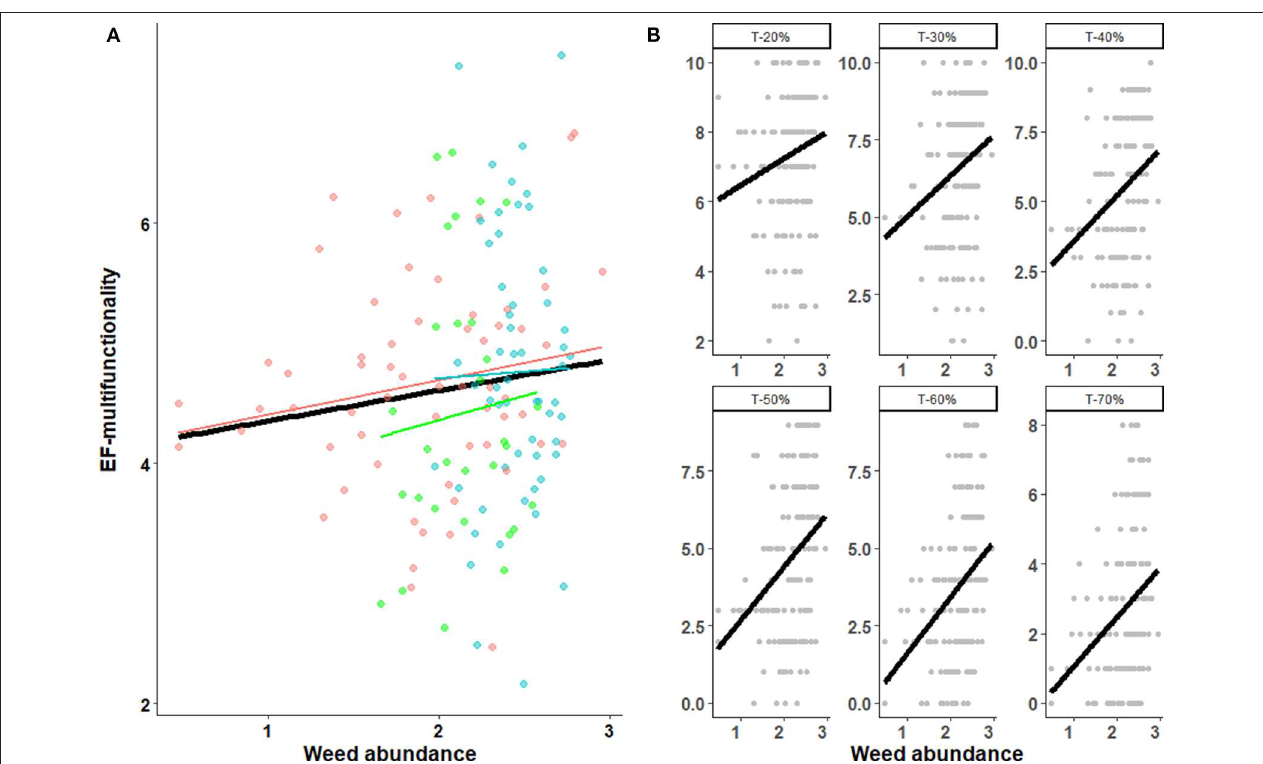
FIGURE 3 | Weed abundance effects on EF-multifunctionality (A) and across functional thresholds (B) measured as the number of functions achieved in each field above thresholds (T), where T is the quantile-based ranking of each function across all fields. EF-multifunctionality was computed using the averaging approach. Lines represent the predicted relationship from the statistical models and shade areas the 95% confidence interval. Colors indicate the different crop type (cereals in red, oilseed rape in green and haylands in blue). Weed abundance is log-transformed.